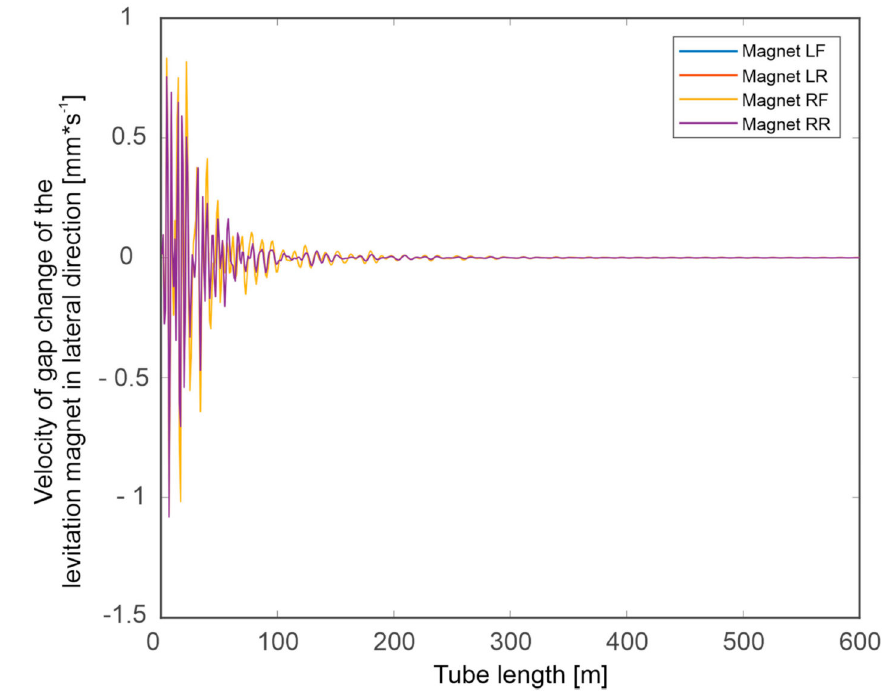
Figure 7. The speed of the gap width change on the levitation magnet in the lateral direction obtained at the capsule speed of 1000 km /